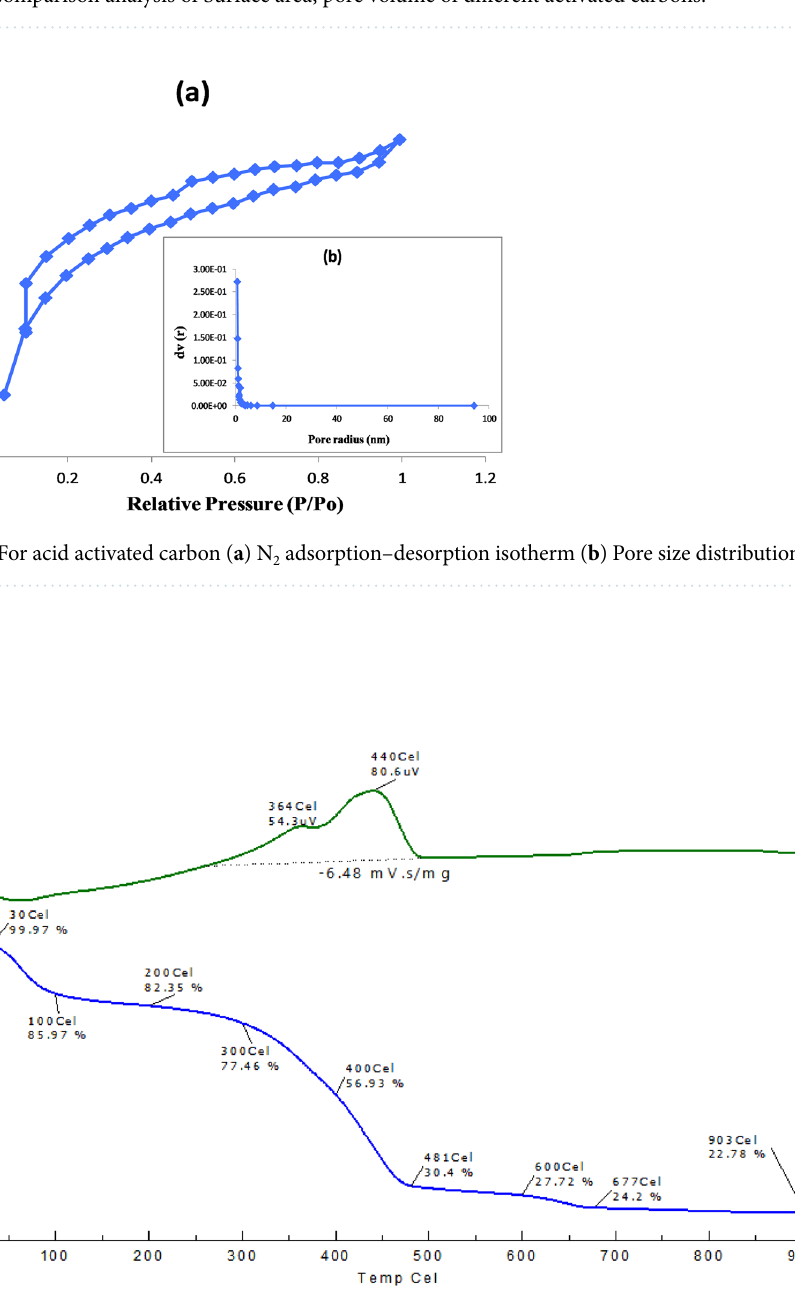
Figure 6. TG–DTA curve of the AAC-CC